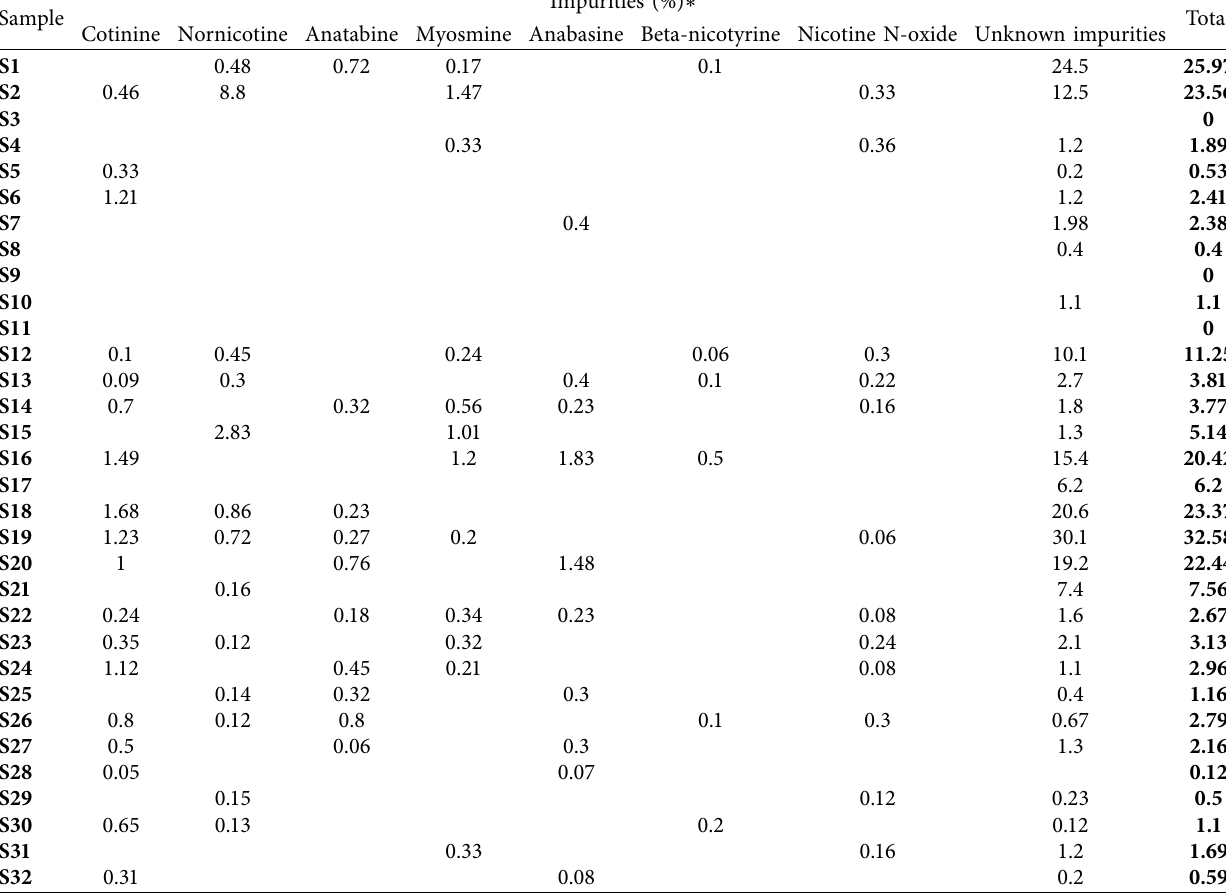
Table 1: Amount of impurities related to the degradation of nicotine and unidentified impurities expressed as a percentage of the nicotine